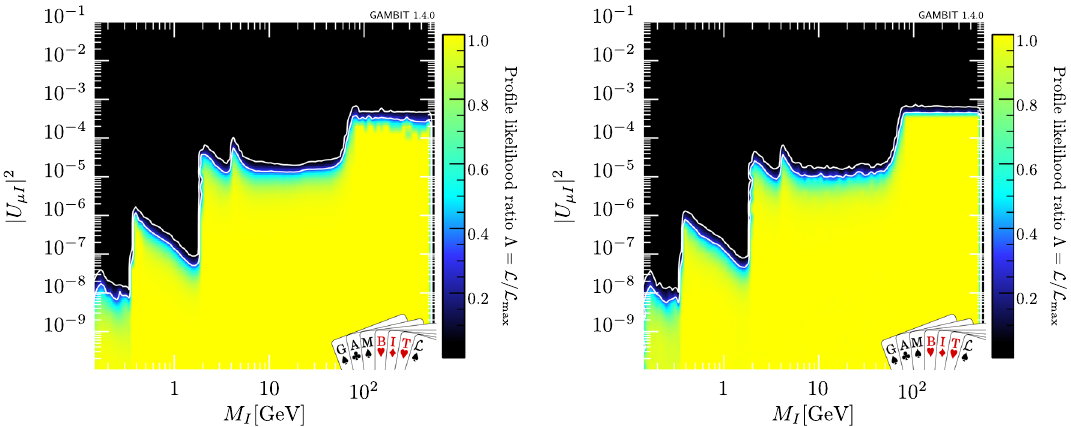
Fig. 2 Profile likelihood in M I vs U 2 μ plane for normal (left) and inverted hierarchy (right). Tables with the 90% and 95% CLs for both hierarchies I can be found in Zenodo [186]